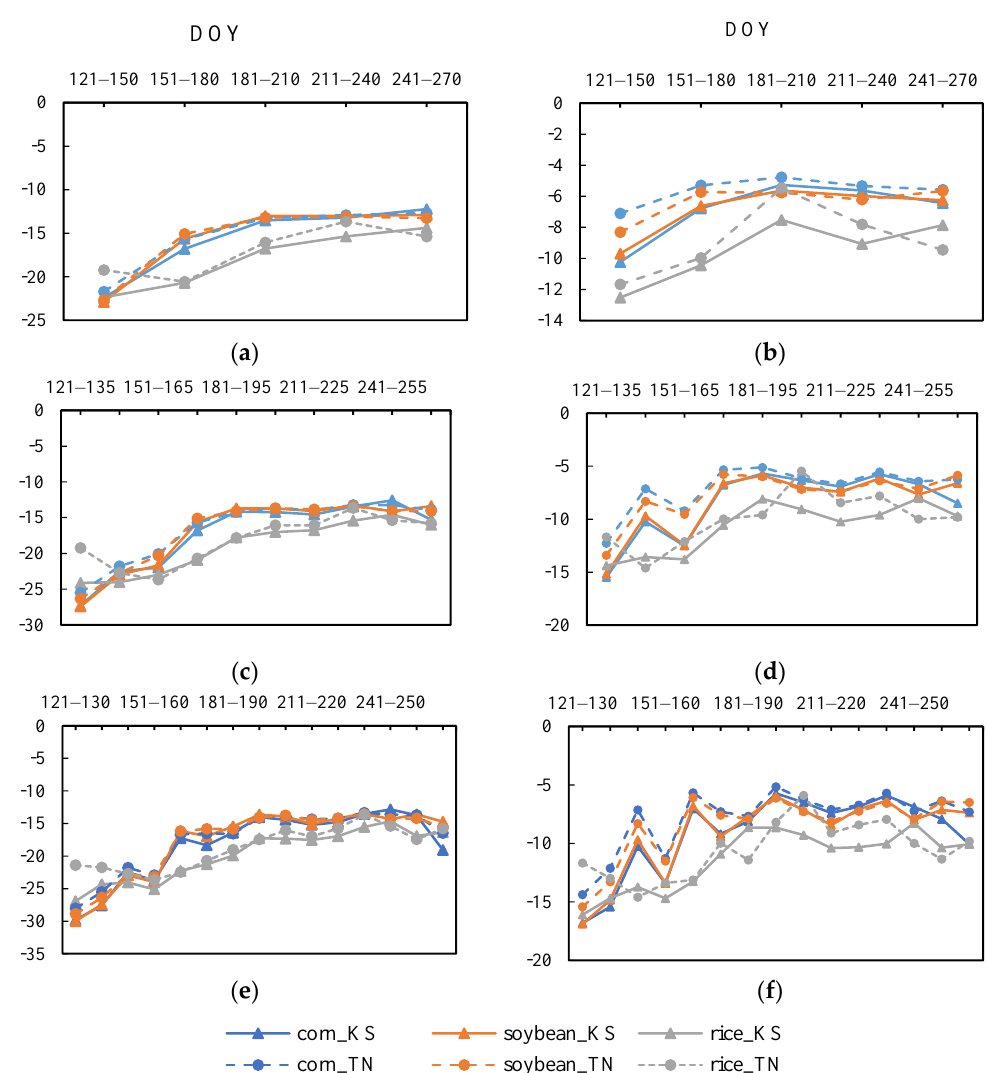
Figure 3. Variation characteristics of the average values of the polarization bands (VV and VH) of all samples of different crops in Keshan farm and Tongnan town with different time intervals (( a ), VH_30d; ( b ), VV_30d; ( c ), VH_15d; ( d ), VV_15d; ( e ), VH_10d; ( f ), VV_10d).